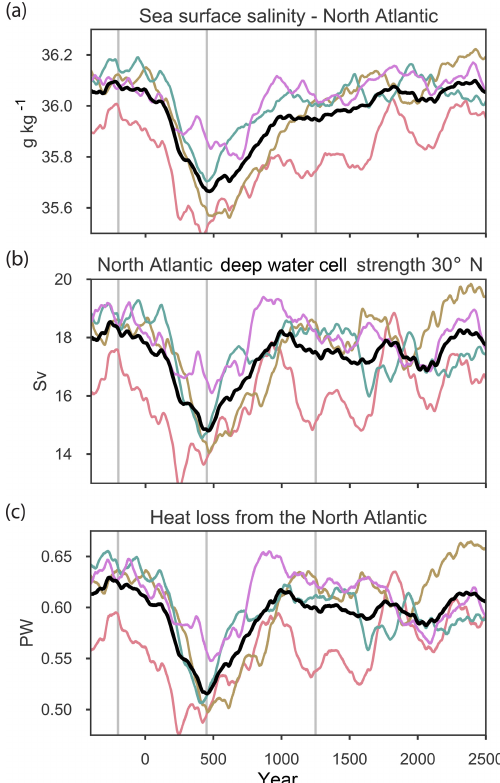
Figure 8. (a) North Atlantic Sea surface salinity, (b) NADW cell strength at 30 ◦ N, and (c) North Atlantic heat loss. 300-year running means. Colors as in Fig. 1, vertical lines as in Fig.